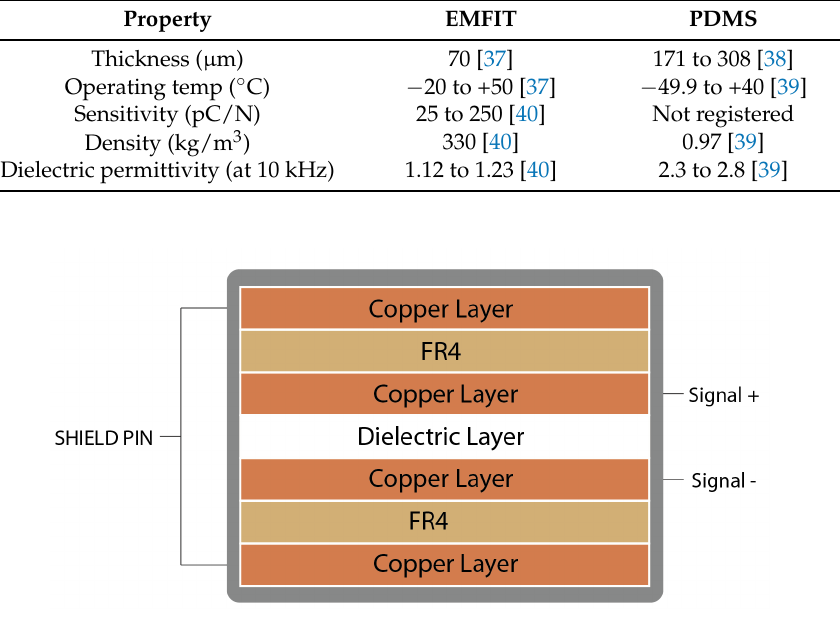
Figure 4. Layer scheme of the designed sensors © 2018 IEEE